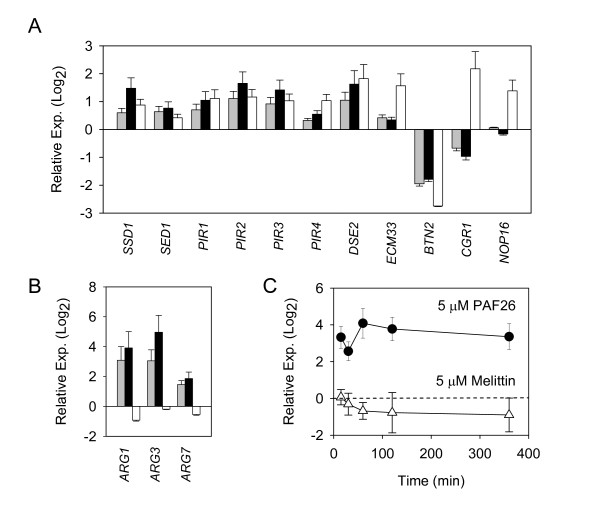
Quantitative real time PCR analysis of gene expression changes after peptide treatment. All the panels show the mean relative expression ± SD (y-axis) of each individual gene upon each peptide treatment as compared to the control treatment with no peptide. (A) and (B) graphs are end-point analyses of expression of the indicated genes (x-axis) after 3 h of peptide treatment; grey bars indicate 5 μM PAF26, black bars 25 μM PAF26, and white bars 5 μM melittin. Note the different expression scales in panels (A) and (B). (C) Graph shows time-course changes of expression of ARG1 following treatment with either 5 μM PAF26 or 5 μM melittin. In all the panels, the genes ALG9, TAF10 and UBC6 were simultaneously used as constitutive references (see Methods for details).